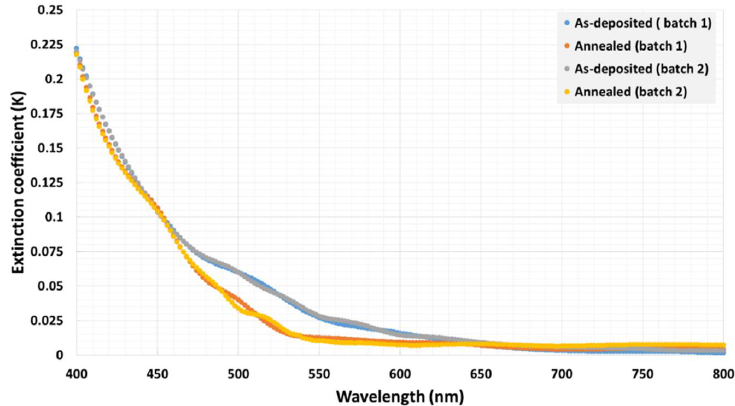
Figure 11. Spectral dependence of the extinction coefficient for as-deposited and annealed garnet samples (batch 1 and 2).